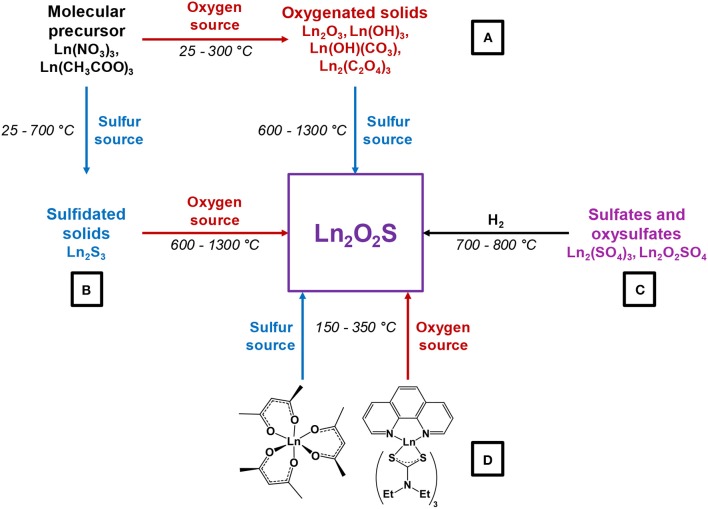
Synthetic strategies toward Ln2O2S.